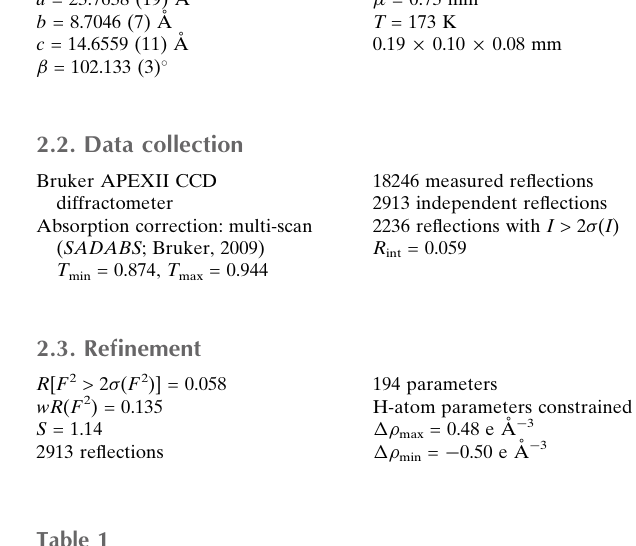
Hydrogen-bond geometry (A˚ , (cid:2)